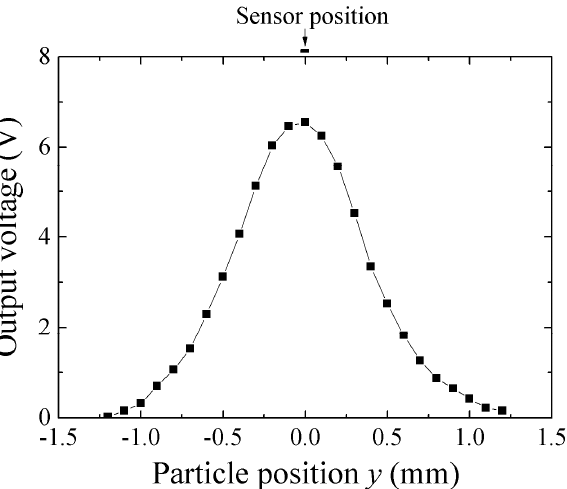
Figure 27. Result of experimental measurement of scanned magnetic small particle along transverse direction, y , on x = 0 [21].